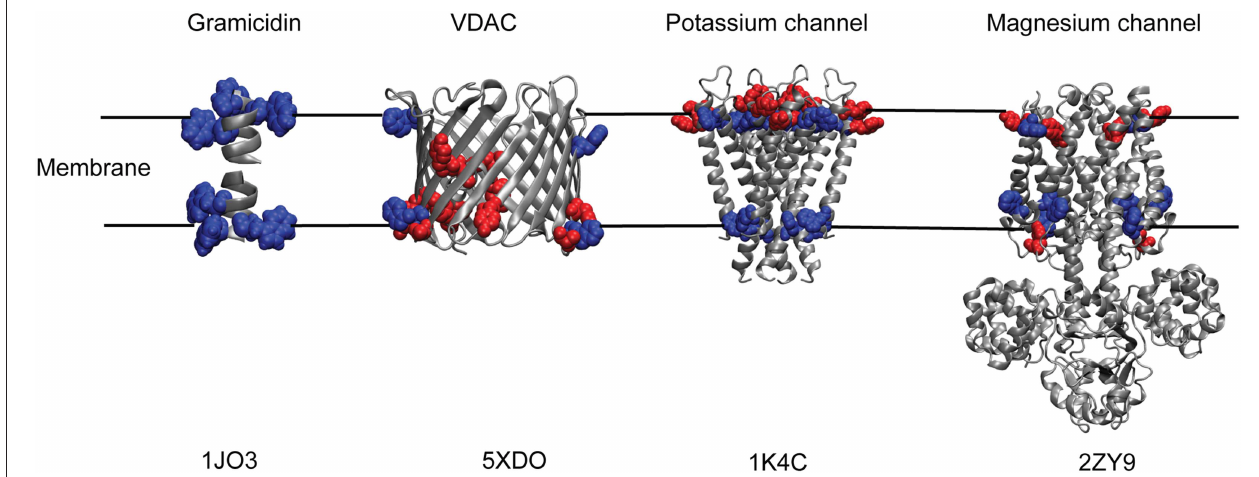
FIGURE 2 | “Aromatic ring” formed by Trp and Tyr residues of membrane proteins at the membrane interface. Cartoon representations of Gramicidin A; human voltage-dependent anion channel, VDAC; potassium channel, KcsA and magnesium channel, MgtE with their respective tryptophan (blue) and tyrosine (red) residues depicting the membrane interfacial localization of the aromatic ring. Only the transmembrane Tyr and Trp residues are shown for MgtE. PDB IDs of the respective protein are indicated below each representation. See text for